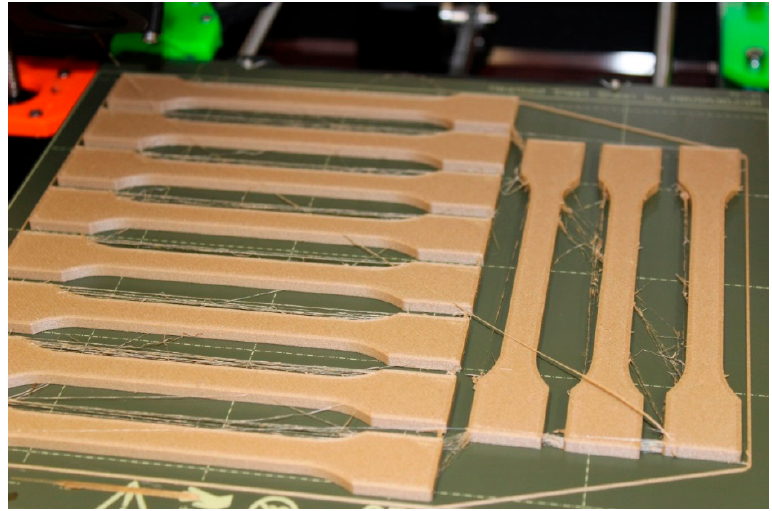
Figure 2. 3D printing kit for PLA/B/nozzle 0.4 mm/60% test